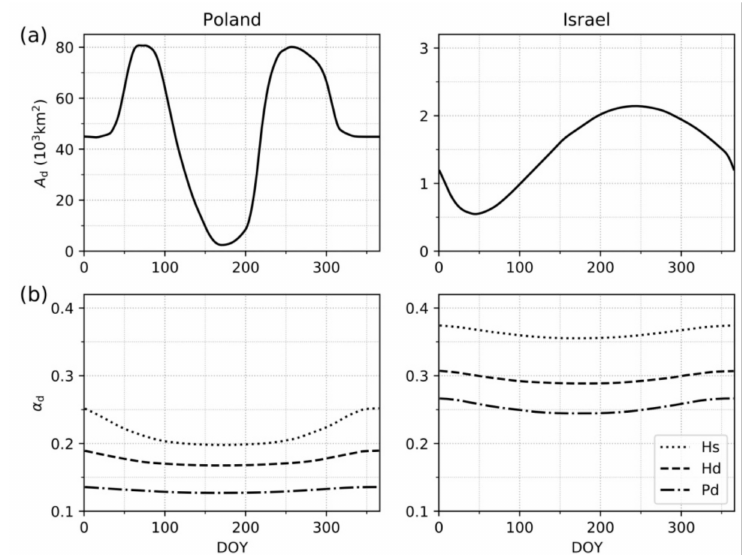
Figure 4. Annual variations in Poland and Israel: ( a ) Daily bare arable land area ( A d ); ( b ) Average daily albedo ( α d ) of the bare soils within arable land, formed by a plow (P d ), a disk harrow (H d ), and a smooth harrow (H s ). The values of A d and α d in Poland are averaged for the whole of Poland from the values specified for the ES and WS Landsat images (scene numbers 187/024 and 190/024) in